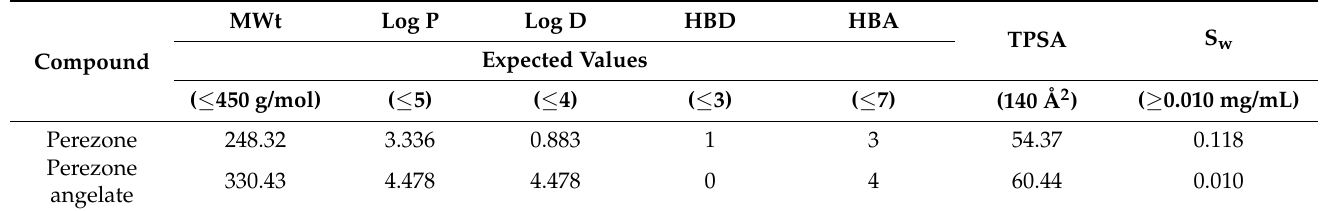
Table 1. Parameters joined with Lipinski’s rule of five, the theoretical values of the topological polar surface area (TPSA), and water solubility (S w ) for perezone and perezone angelate.